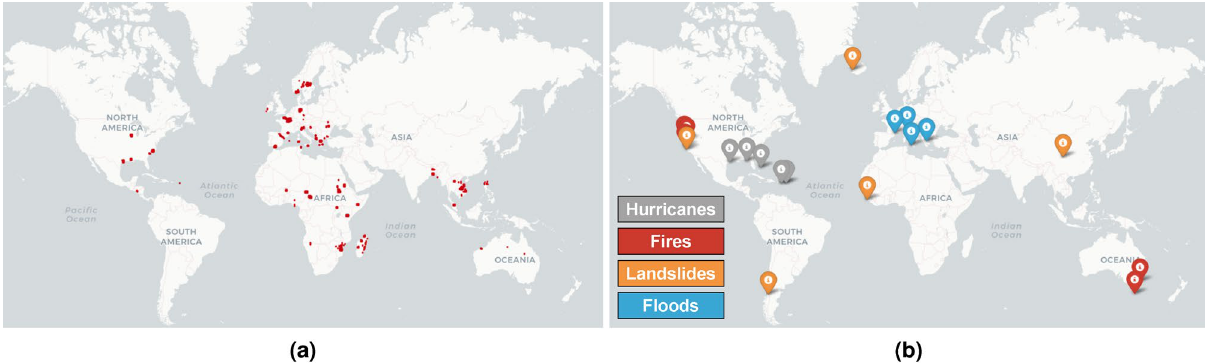
Figure 1. Locations used for training ( a ) and validation ( b ) images.